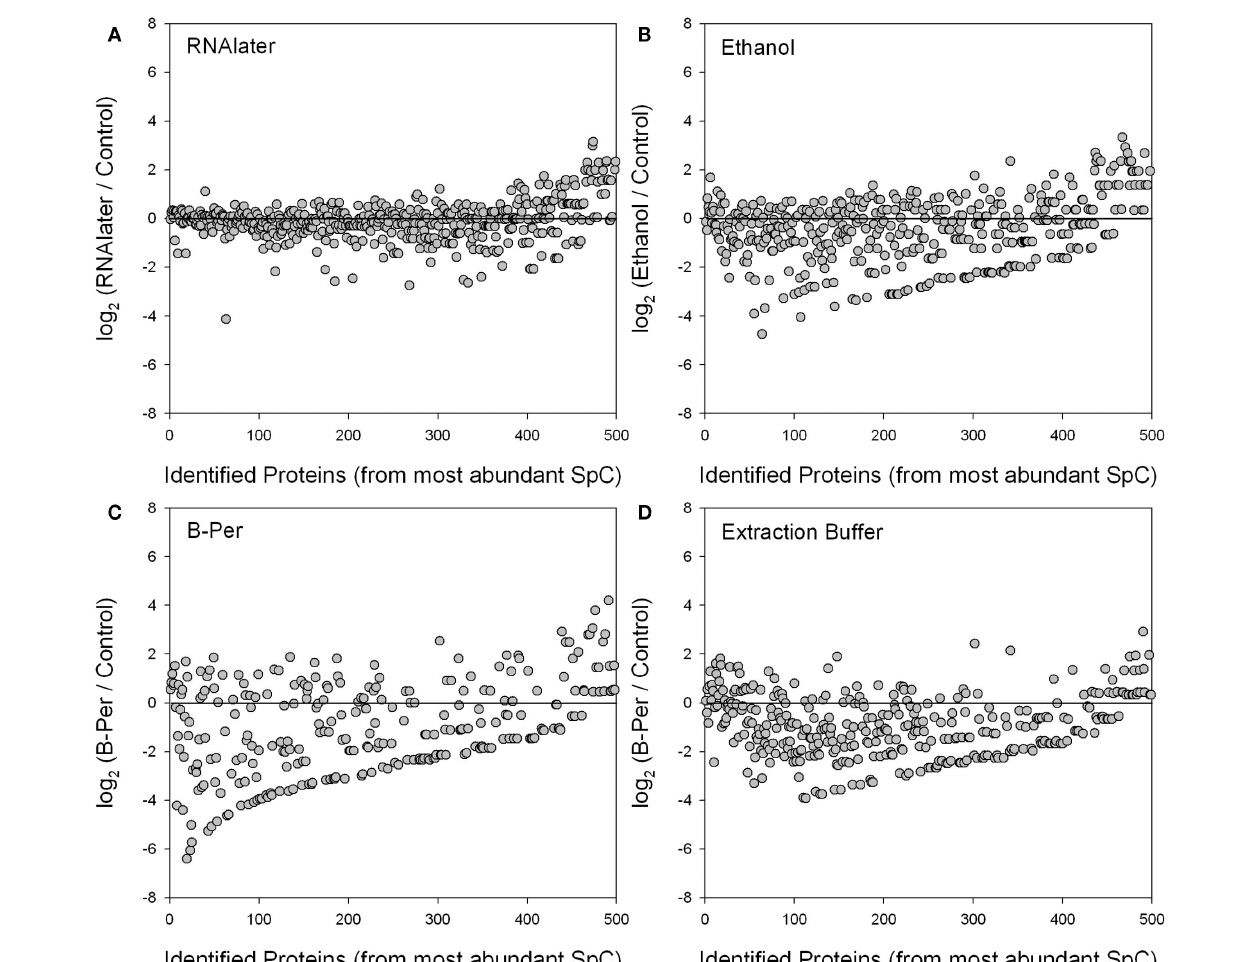
FIGURE 5 | Log 2 ratios of individual protein relative abundances (average of technical duplicates) identified in each of four preservatives (RNA later, ethanol, B-PER, and SDS-extraction buffer) relative to the control treatment (average of technical duplicates). The proteins are ordered on the horizontal axis from those with the highest number of normalized spectral counts (SpC). Log 2 ratios close to zero (horizontal lines) reflect similar normalized spectral count scores for each protein between that preservative and the control, while deviation below the line indicates lower abundance in the preserved sample than the control due to degradation. Normalization and weighting of spectral counts results involves normalizing to the total number